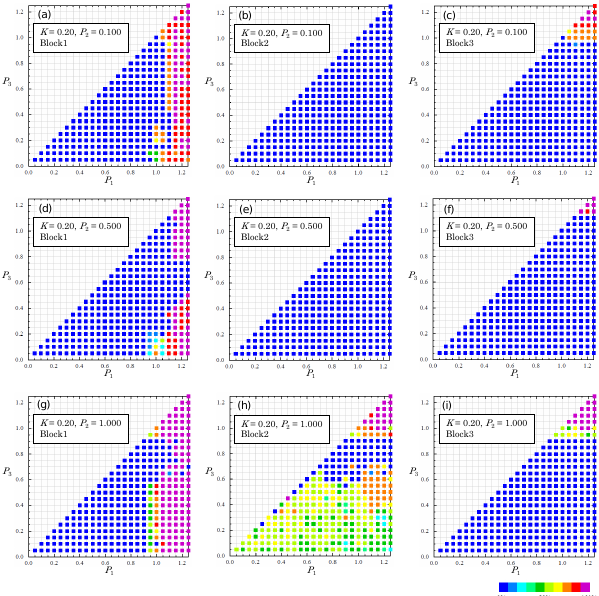
Figure 3. The ratio of aseismic slip events to total slip events for the case of K = 0 .